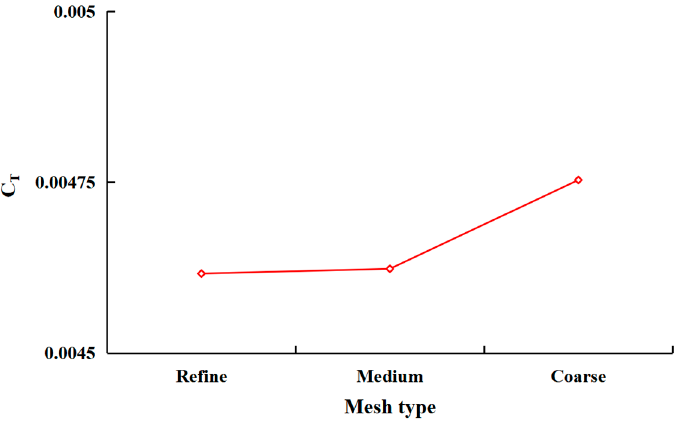
Figure 5. The total resistance coefficients C T obtained using different mesh types.